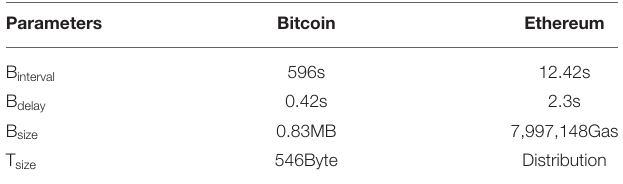
TABLE 2 | Data gathered from Bitcoin and Ethereum, serves as input to the simulation runs used as